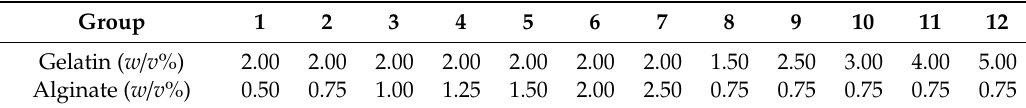
Table 1. Formulations of hydrogels.